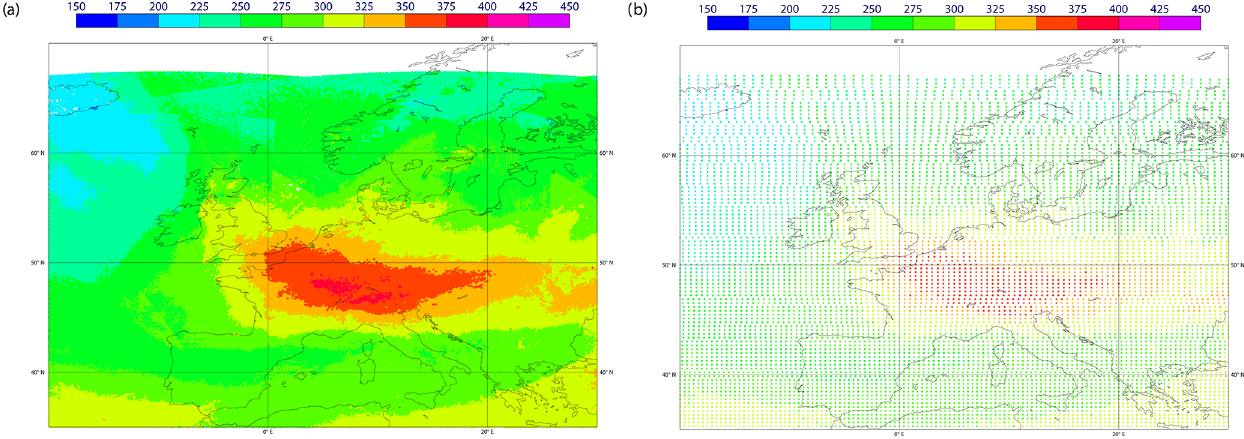
Figure 1. TROPOMI NRT TCO3 in Dobson units (DU) at (a) full resolution and (b) super-obbed to the model resolution of T511 on 29 November 2017, 12:00UTC over